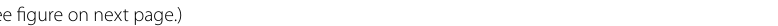
0.01)(See figure on next Fig. 10 ERS inhibits ROS levels in kidney tissue of mice and HK-2 cell. A The expressions of GPR78 and SOD1 in the kidney of model mice were detected by immunofluorescence. B , C The level of ROS in HK-2 cell model was detected by fluorescence microscope and flow cytometry. D Western blot was used to detect the expression of ERS and ROS related proteins protein in HK-2 cell model. (*compared with normal control group, P < 0.05.* (Red) Compared with control group, P < 0.01. # Compared with oxalate group, P < 0.05. #(Red) Compared with oxalate group, P <